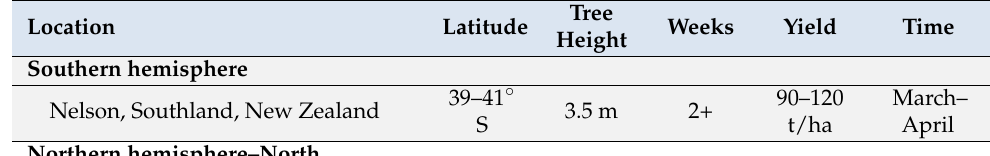
Table 5. Influence of latitude and tree size on minimum exposure time of reflective